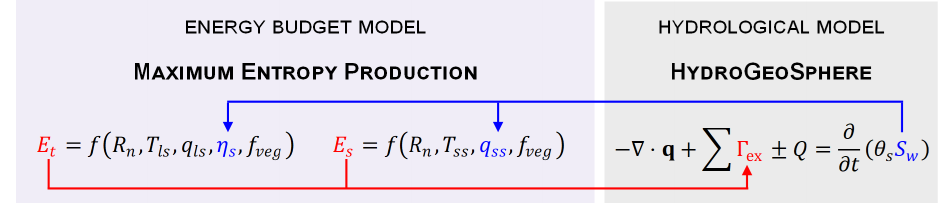
Figure 2. Coupling of the HydroGeoSphere (HGS) hydrological model and the maximum entropy production (MEP) model of land surface fluxes. HGS supplies the MEP model with soil water saturations ( S w ; in blue), which are used by the MEP model to compute the transpiration ( E t ) and evaporation ( E s ) rates. These rates are then passed on to HGS to compute the sink terms with the surface ( (cid:48) ex ; in red), and HGS removes water from the soil reservoir based on the root and evaporation depth profiles. Table 2. Soil and vegetation properties at each study site. US-Wkg